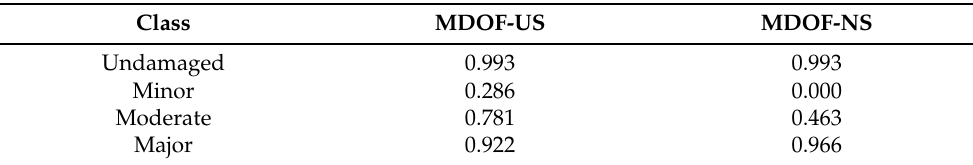
Table 5. Class-specific recall values for the two MDOF models.